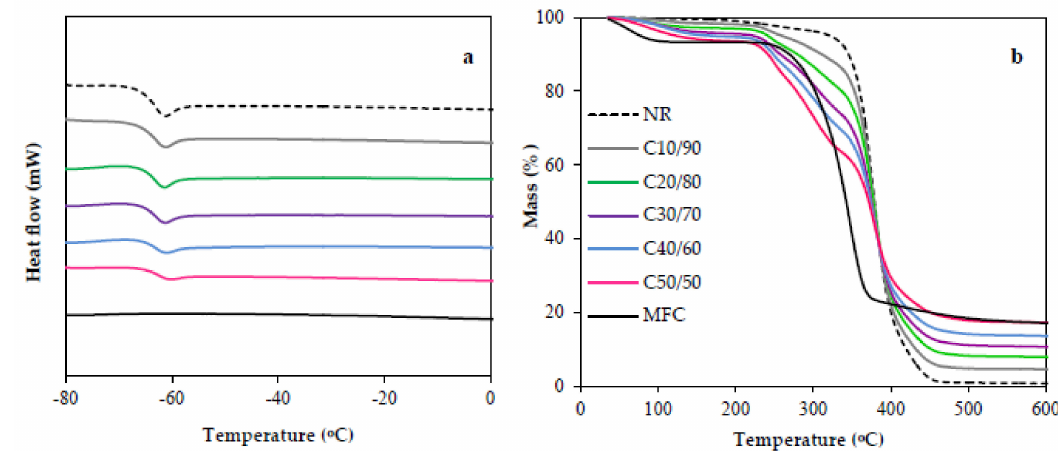
Figure 5. DSC thermograms ( a ) and TGA curves ( b ) of NR, MFC–NRs, and MFC. The thermal degradation was determined by using thermogravimetric analysis